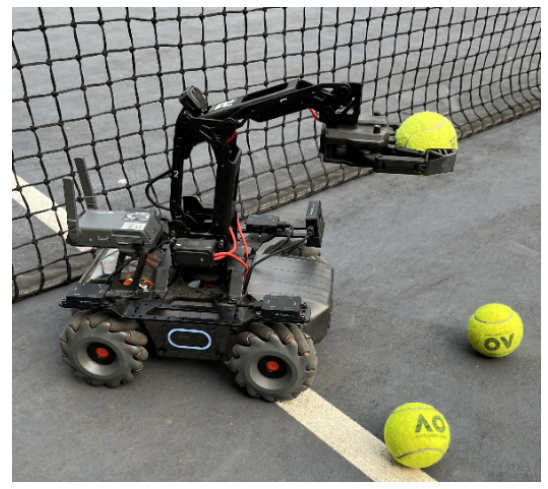
Figure 1. Robomaster